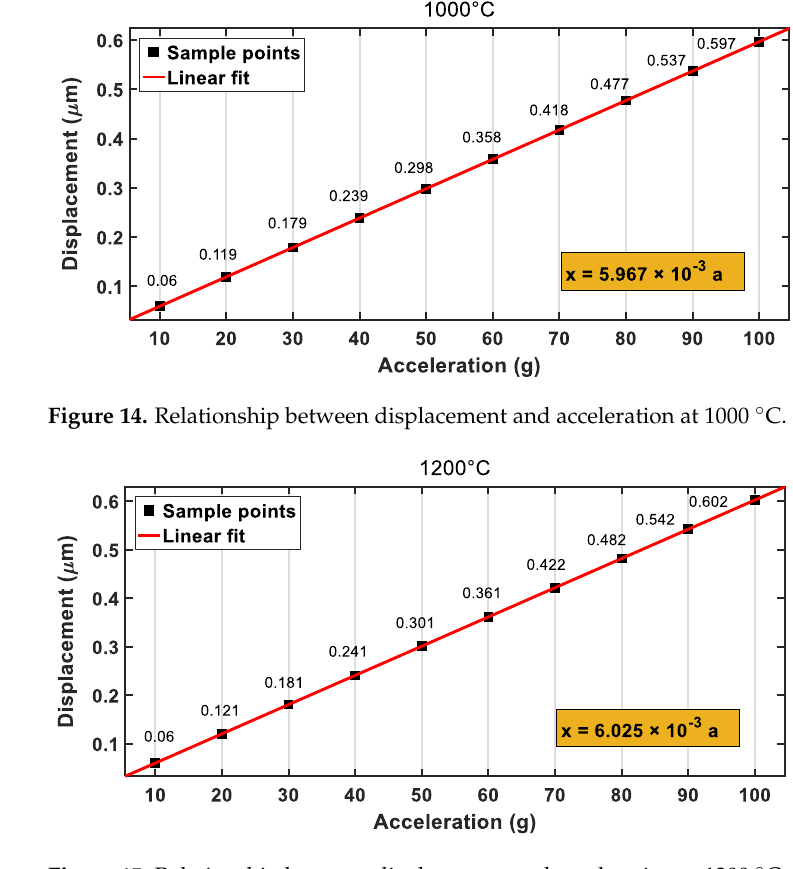
Figure 15. Relationship between displacement and acceleration at 1200 °C.